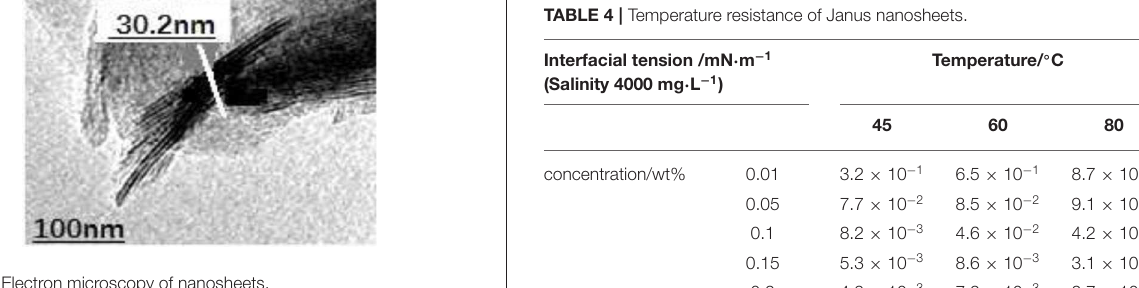
TABLE 4 | Temperature resistance of Janus nanosheets.